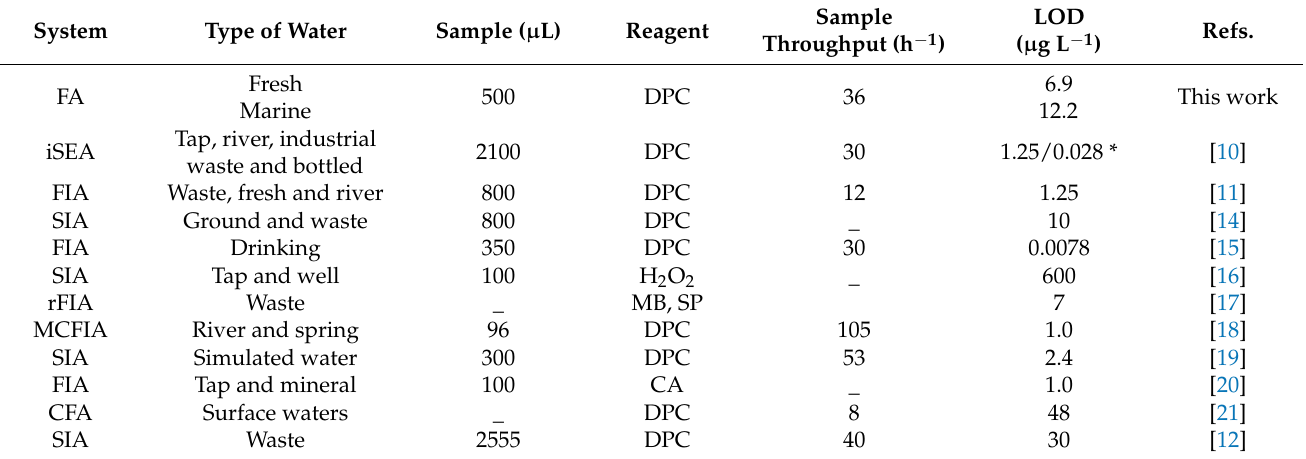
Table 4. Analytical characteristics of developed spectrophotometric flow-based systems for chromium (VI) determination in water samples (presented in descending chronological